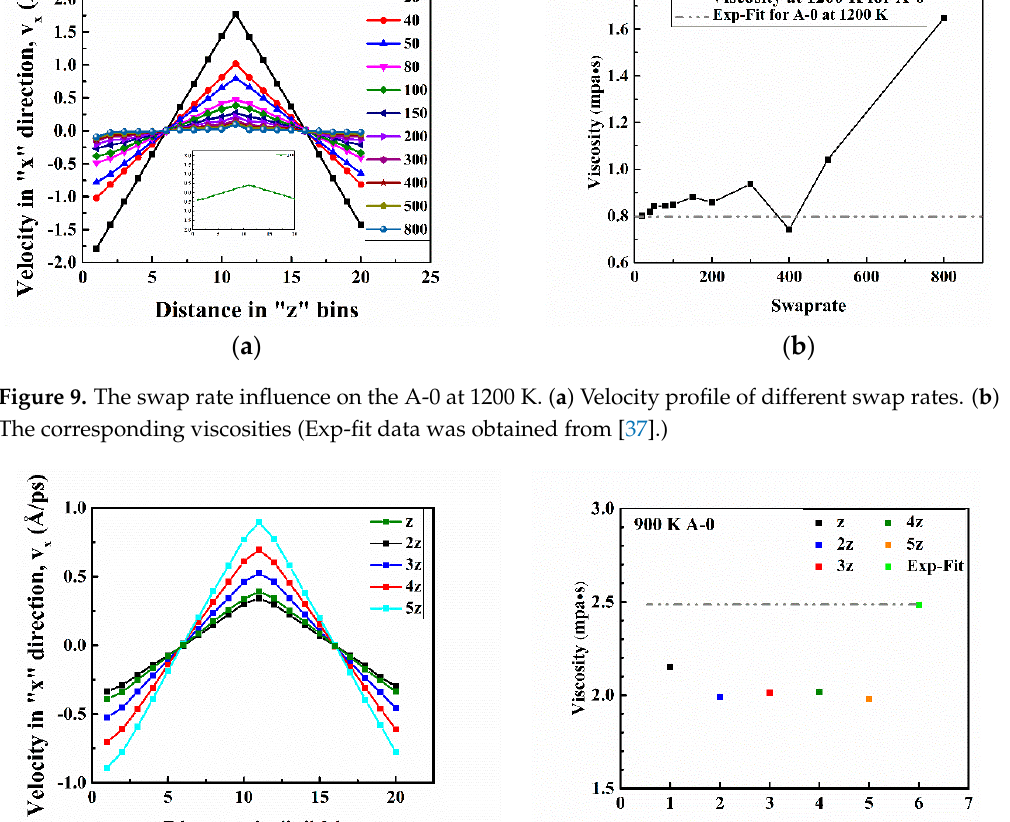
Figure 11. Velocity profile of A-0 at different temperatures. The viscosities obtained from experiments and simulations are plotted in Figure 12. Viscosities calculated by the RNEMD method are in good agreement with the experimental values. The uncertainties of simulated viscosities for A-0, A-2, A-6, and A-8 were under 7%. Since the RNEMD method underestimated viscosities by about 5.8%, 5.2%, and 5.7% for pure molten LiCl, NaCl, and KCl, respectively [26], the simulation results were satisfying. The relatively large discrepancies of A- 4 and A-10 (about 20% discrepancy) could be caused by experimental errors, since the A-4 sample corroded the crucible badly and there were slags in the salts during testing. The viscosity monotonously decreased with the increasing temperature.